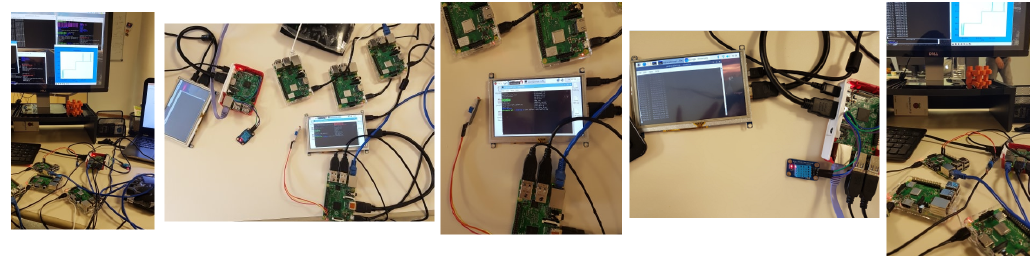
Figure 9. Implementation of